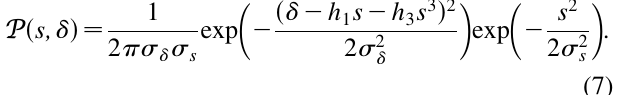
FIG. 3. (Color) Simulation of the zero-phasing method for a distorted incoming longitudinal phase space. (a) and (c) depict the phase spaces after the bunch has passed the zero-phasing traveling wave structure for the ‘‘positive’’ (upper plots) and ‘‘negative’’ (lower plots) zero-crossing points. The plots (b) and (d) are the corresponding projections. In these plots we com- pare the time projections (dashed lines) with the ones deduced from the fractional momentum spread projections (solid lines). The time > 0 corresponds to the bunch tail.